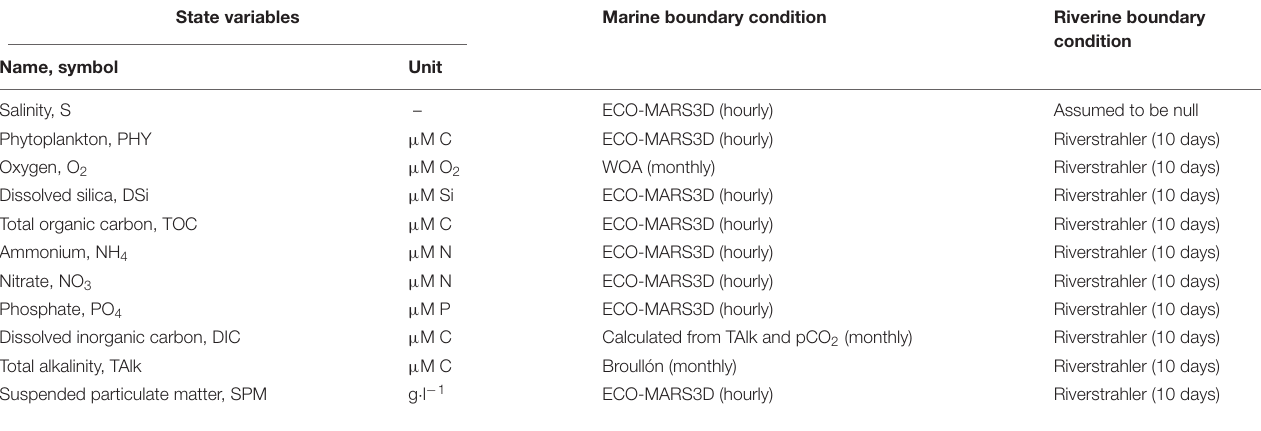
TABLE 2 | State variables of C-GEM and boundary